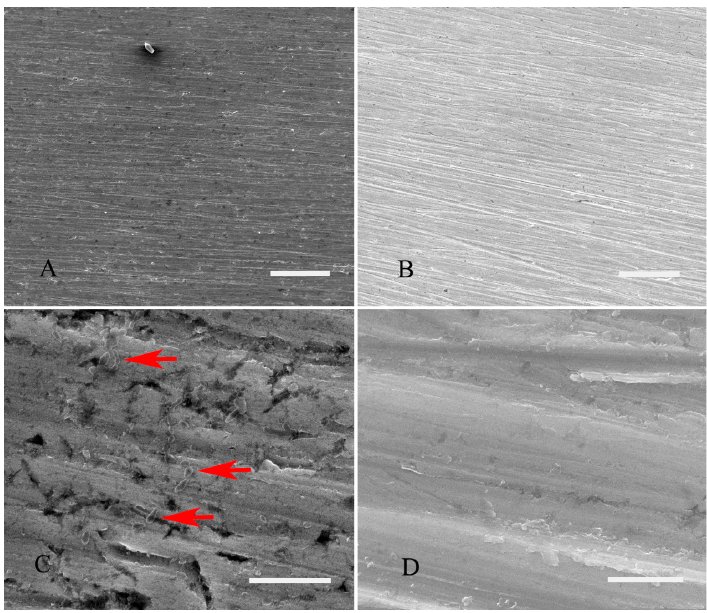
Figure 2. SEM images of titanium in enriched artificial saliva with or without S. sanguis for 336 h. ( A ) with S. sanguis ; ( B ) without S. sanguis ; ( C ) magnified view of (A) ( S. sanguis was indicated with red arrows) and ( D ) magnified view of (B). (Scale bar: A, B, 100 μ m; C, 10 μ m; D, 5 μ m).